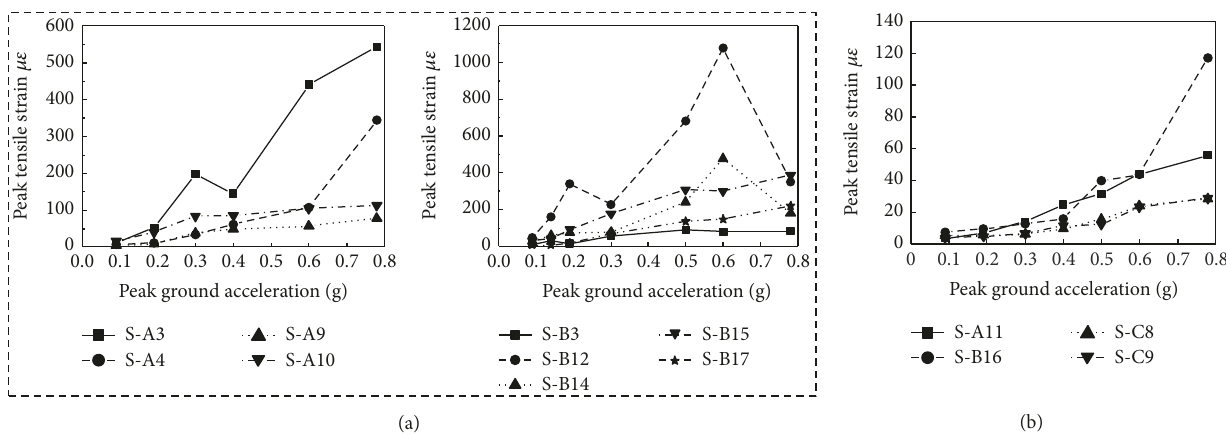
Figure 19: Peak tensile strains under Wolong earthquake records: (a) steel rebar and (b) concrete.